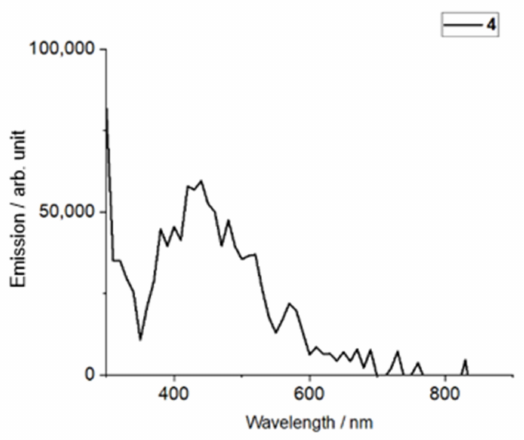
Figure 6. Room-temperature mission spectrum of 4 in the solid state after excitation at 260 nm. These results are interesting when contrasted with the literature known CCC- and CNC-type NHC pincer complexes 8 and 9 (Scheme 4)